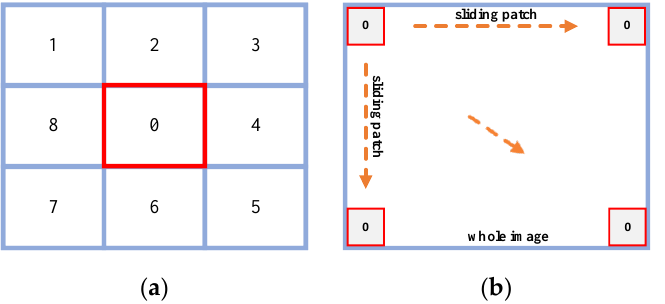
Figure 3. Calculation principle of LAGDM-based saliency map. The red box is the center sub-patch, the patches are the local area around target, and we set the size of all patches as l × l ( l = 3,5,7,9 in this paper). ( a ) Local window region; ( b ) The traversal process of the center sub-patch in the whole image.